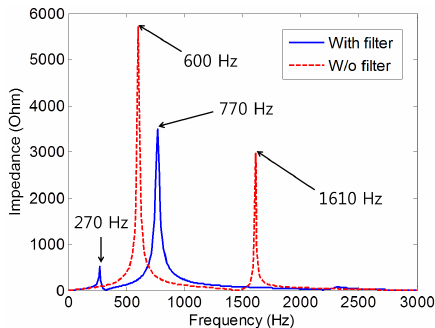
Figure 9. Frequency scan result at the point of connection (PoC). This system has two dominant resonance points: at 270 Hz and 770 Hz. W/o: without.